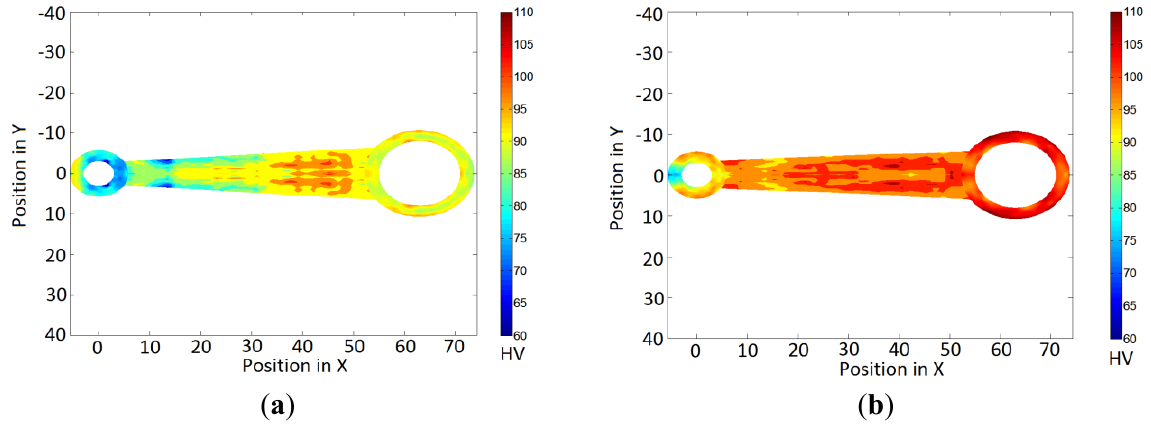
Figure 8. Microhardness values for the optimum connecting rod in each starting state: ( a ) N0 connecting rod forged at 100 °C; ( b ) N2 + flash tr. at 300 °C connecting rod forged at 150 °C.